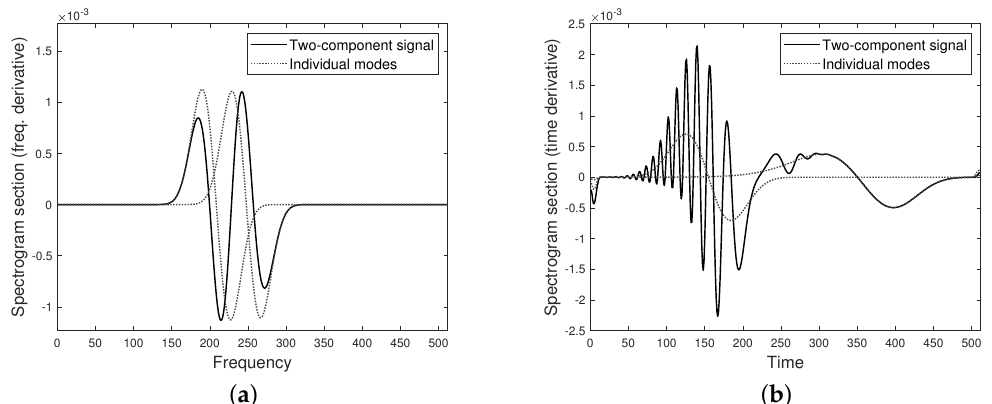
Figure 3. ( a ) Frequency derivative (estimated by central finite differences) at fixed u of spectrogram section in Figure 1d (solid line) compared to the derivatives of the single profiles (dotted lines). Matching is observed for those points lying on the external sides, that is, where the weakened separability condition (WSC) is satisfied. ( b ) Time derivative (estimated by central finite differences) of the spectrogram in Figure 1a (solid line) at fixed ξ , compared to the derivative of the single profiles (dotted lines). Profiles significantly differ on the whole